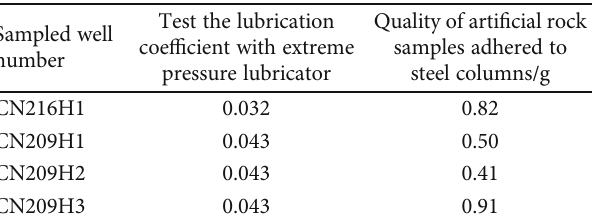
Figure 5: Picture of accretion on steel bar for the accretion test, Note: (a) CN209H2 and CN209H1 from left to right; (b) from left to right, and it is CN216H1 and CN209H3. Table 1: Lubrication and anti-accretion test